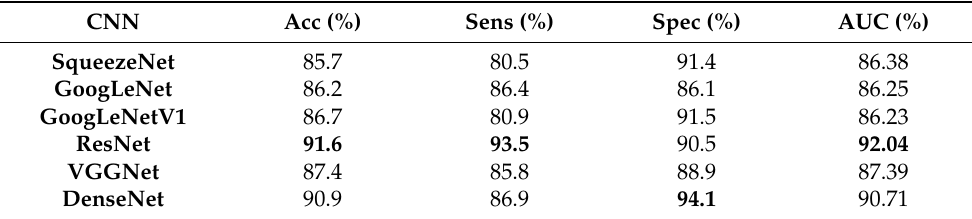
Table 1. The highest value for each column is emphasized with bold characters. As can be noticed, the best accuracy, of 91.6%, the best sensitivity, of 93.5%, the highest AUC, of 92.04%, were obtained for the ResNet architecture, the best specificity, of 94.1%, resulting for the DenseNet architecture. The GoogLeNetV1 classifier achieved an accuracy of 86.7%, which was superior to the accuracy of the SqueezeNet and standard GoogLeNet architec- tures, but also closed to that of VGGNet, while the training time of 136 min and 48 s was more decreased than the training time of VGGNet (200 min). Table 1. The values of the performance parameters obtained when providing the CEUS images at the Convolutional Neural Network (CNN) inputs.